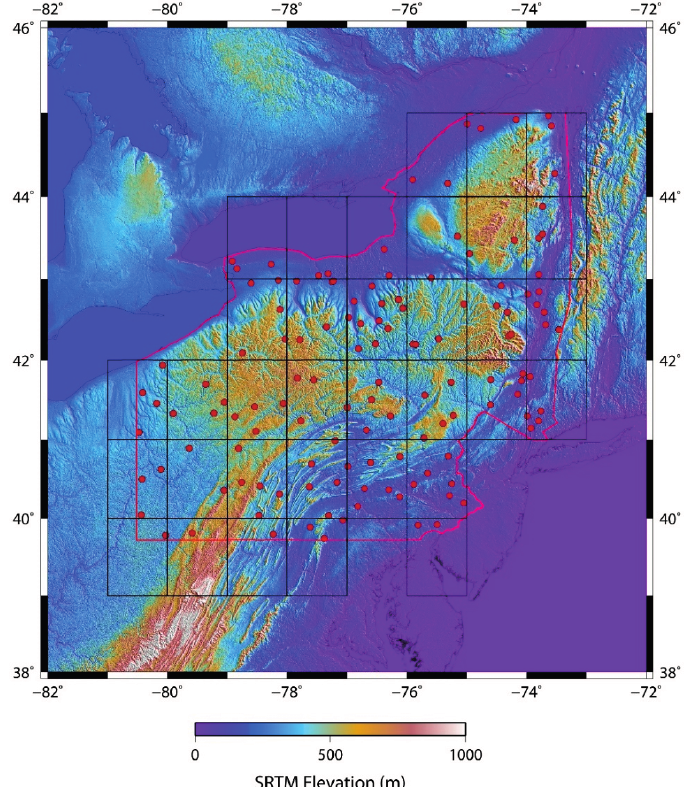
Figure 1. Study area (surrounded by the red curve) in the northern part of the Mid-Atlantic region of the United States and distribution of groundwater monitoring wells (red dots) used from the U.S. Geological Survey Ground-Water Climate Response Network. The area of this region is about 250,000 km 2 . The black rectangles represent the 1° × 1° grid cells as